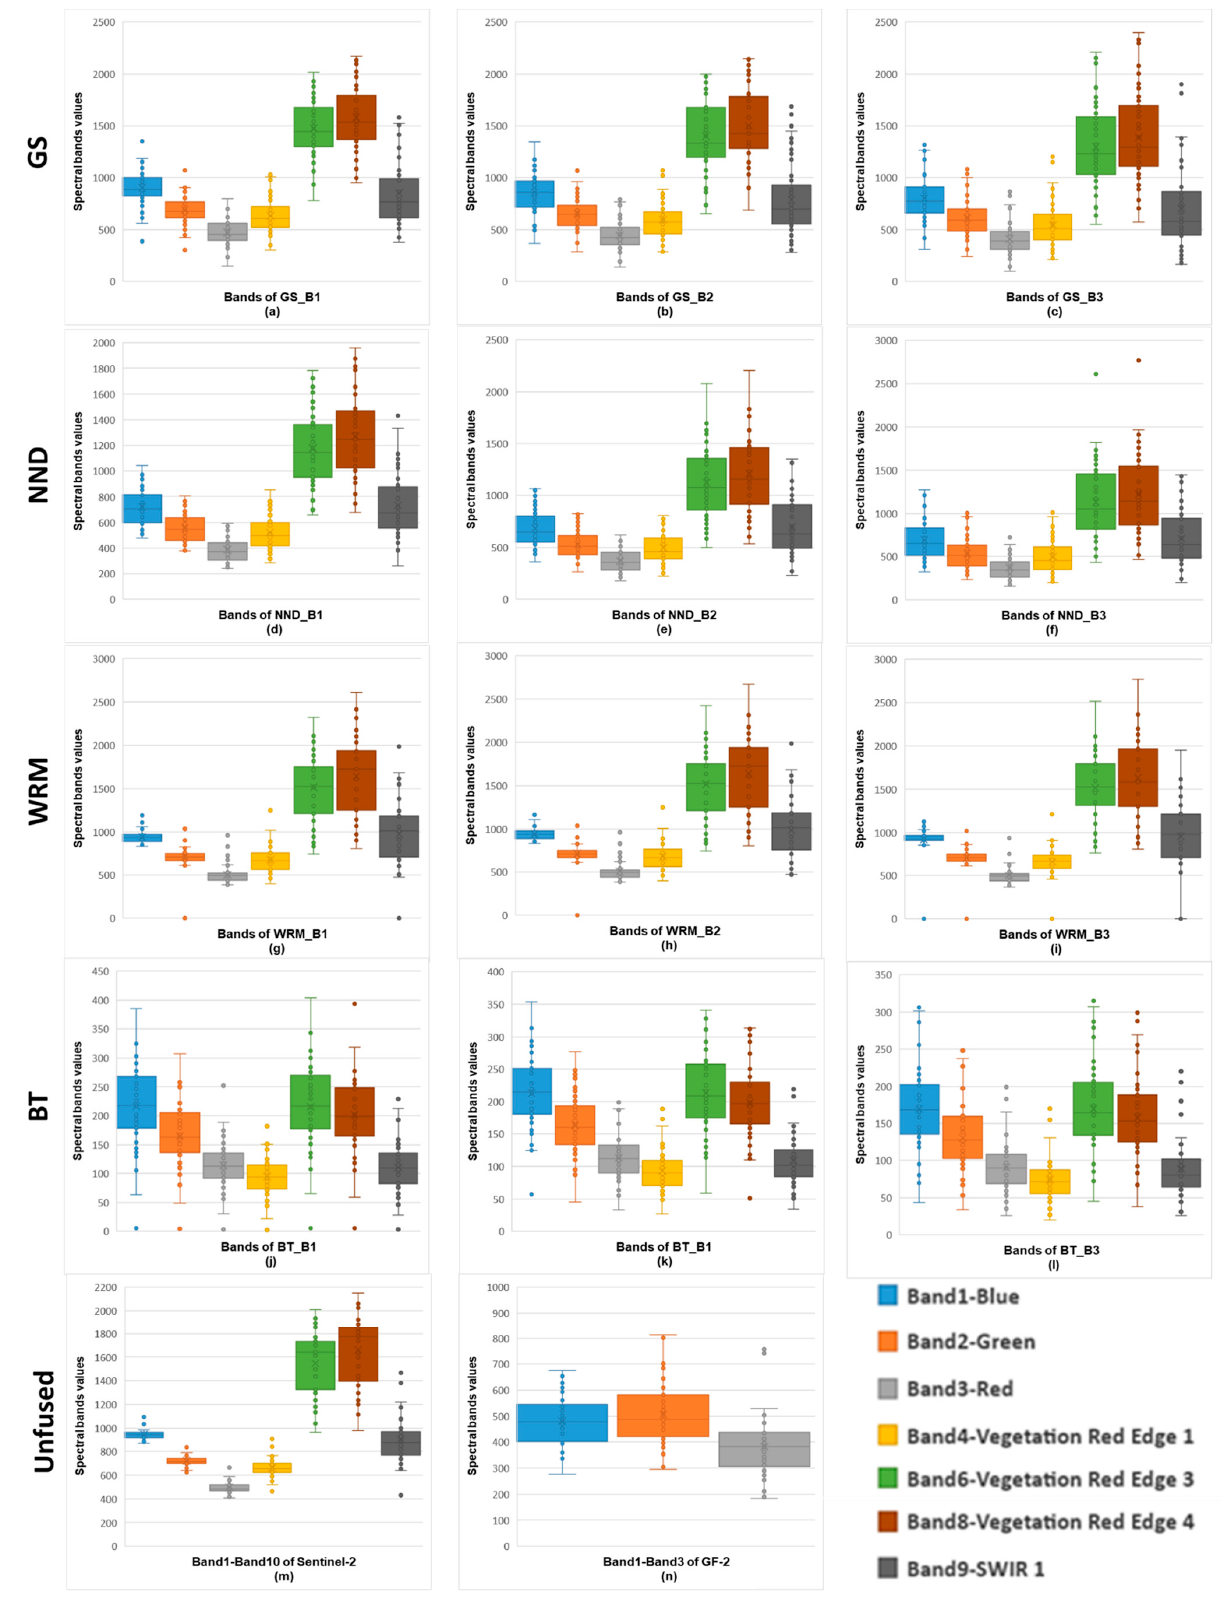
Figure 5. Reflectance distribution range of some representative spectral bands of fused sentinel-like, Sentinel-2, and GF-2 images. ( a – c ) GS_B1-GS_B3; ( d – f ) NND_B1-NND_B3; ( g – i ) WRM_B1-WRM_B3; ( j – l ) BT_B1-BT_B3; ( m ) Sentinel-2; ( n ) GF-2.